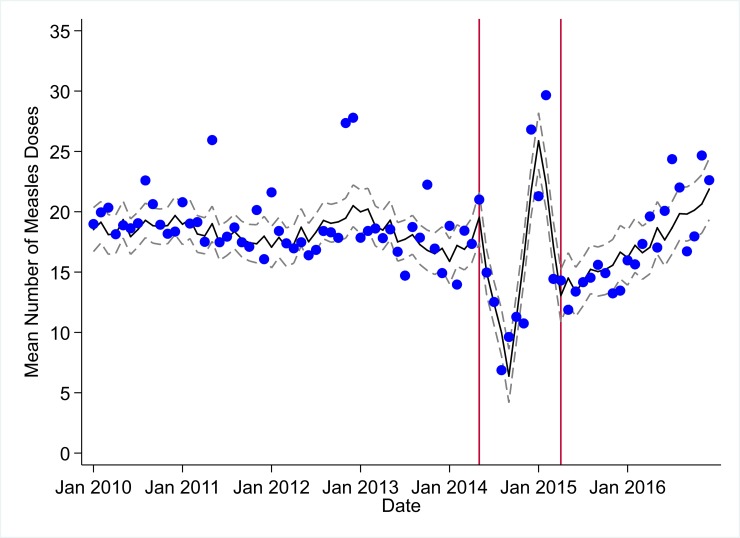
Mean trends and system losses due to Ebola virus disease (EVD) outbreak (June 2014–April 2015) for measles vaccinations in a census of 379 clinics providing services in Liberia from 2010–2016, excluding Montserrado County.The black solid line represents the fitted mean from a linear mixed model using a segmented regression parameterization, random intercepts and slopes by facility, monthly indicator variables to adjust for seasonality, a fixed effect to adjust for clinic-level catchment area, and an AR(1) structure to account for autocorrelation in residual errors. Gray dashed lines are 95% confidence intervals around the fitted mean. Red lines are placed at the final month before the start (May 2014) and end (April 2015) of the EVD outbreak in Liberia.